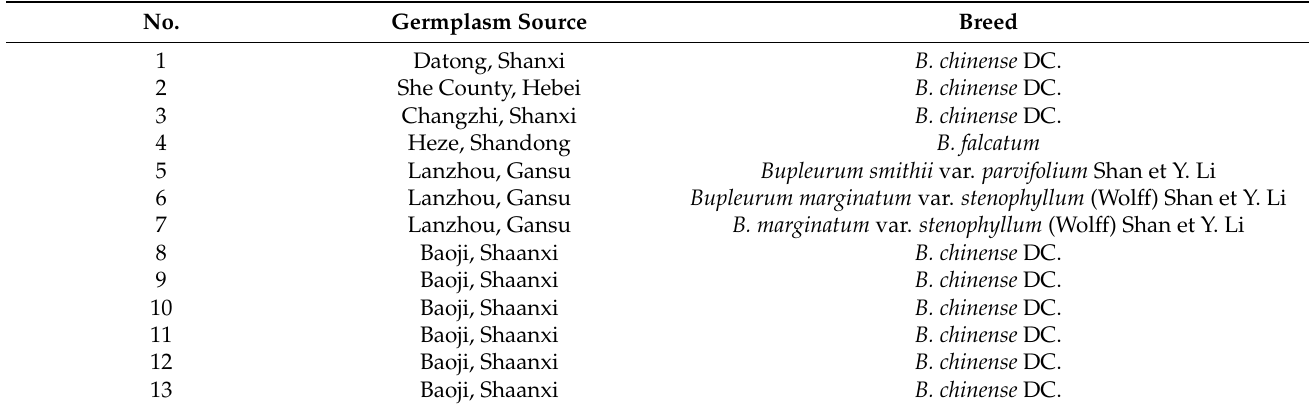
Table 1. Specific information of Radix bupleuri resources.